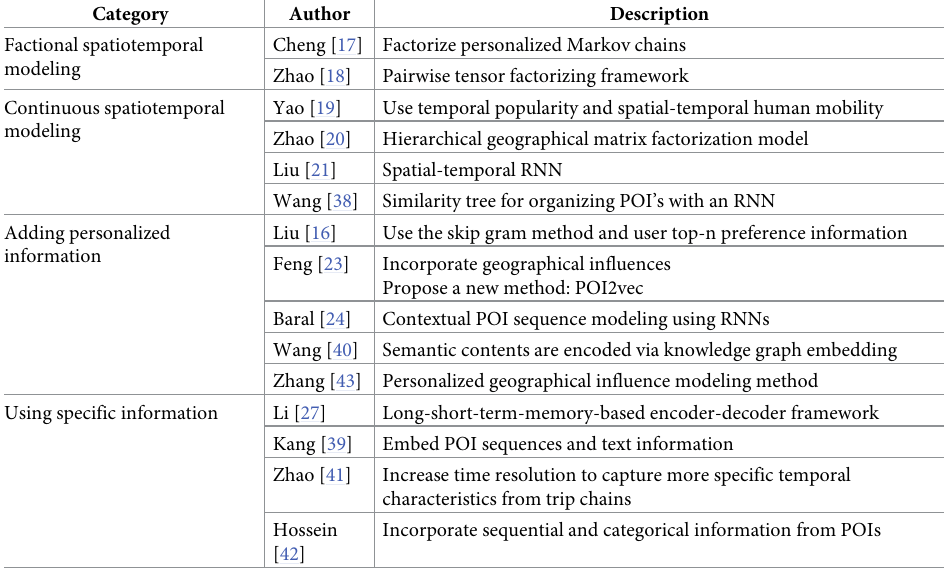
Table 8. Summary of related